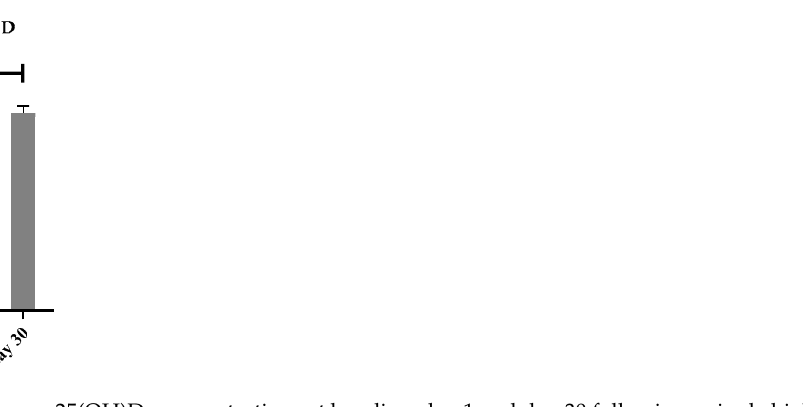
Figure 2. Mean serum 25(OH)D 3 concentrations at baseline, day 1 and day 30 following a single high dose of vitamin D 3 supplementation (n = 50). Error bars show SEM. **** p < 0.0001.